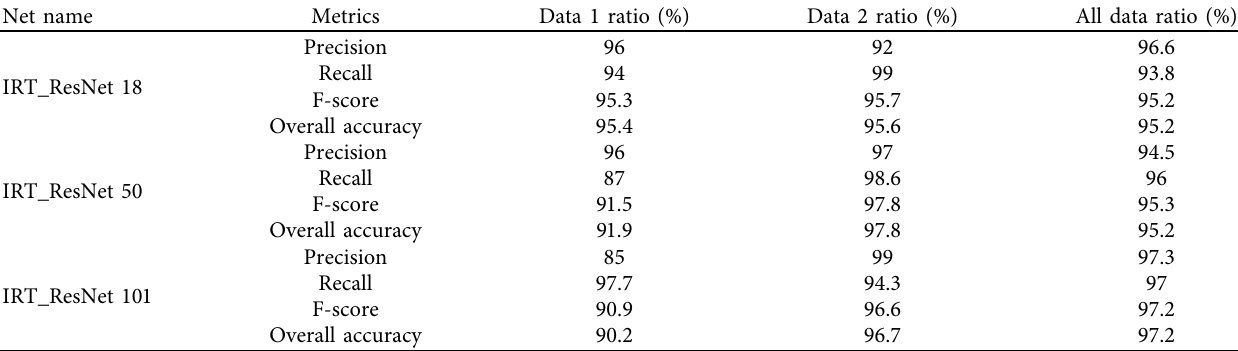
Table 3: The Performance measures of the proposed IRT_ResNet models.